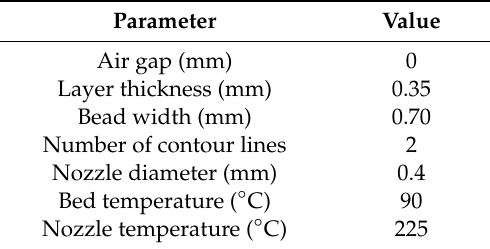
Table 3. FFF process parameters.